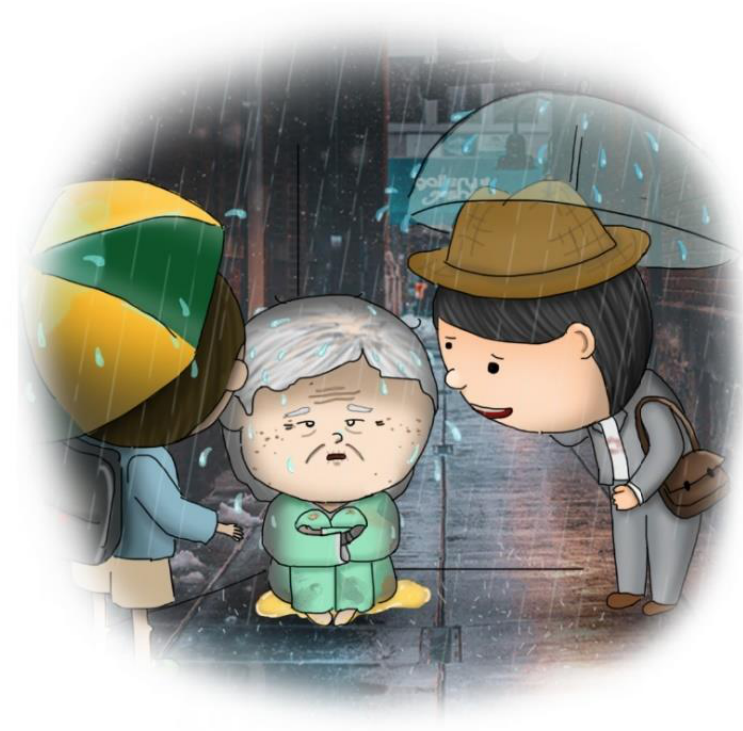
Figure 2. Severe dementia.